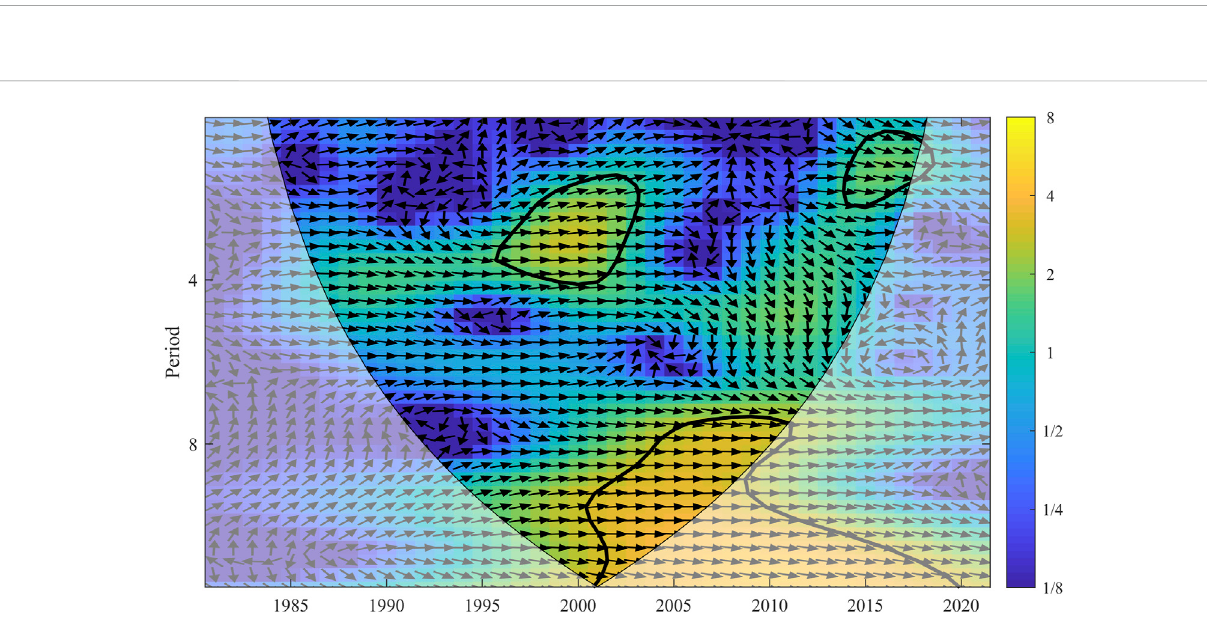
Cross-waveletpowerspectraofannualsedimentloadandannualrainfallerosivity.The95%con fi dencelevelofsigni fi canceforrednoiseisindicated by a thick outline, and the relative phase relationship is indicated by an arrow (in-phase points to the right, anti-phase refers to the